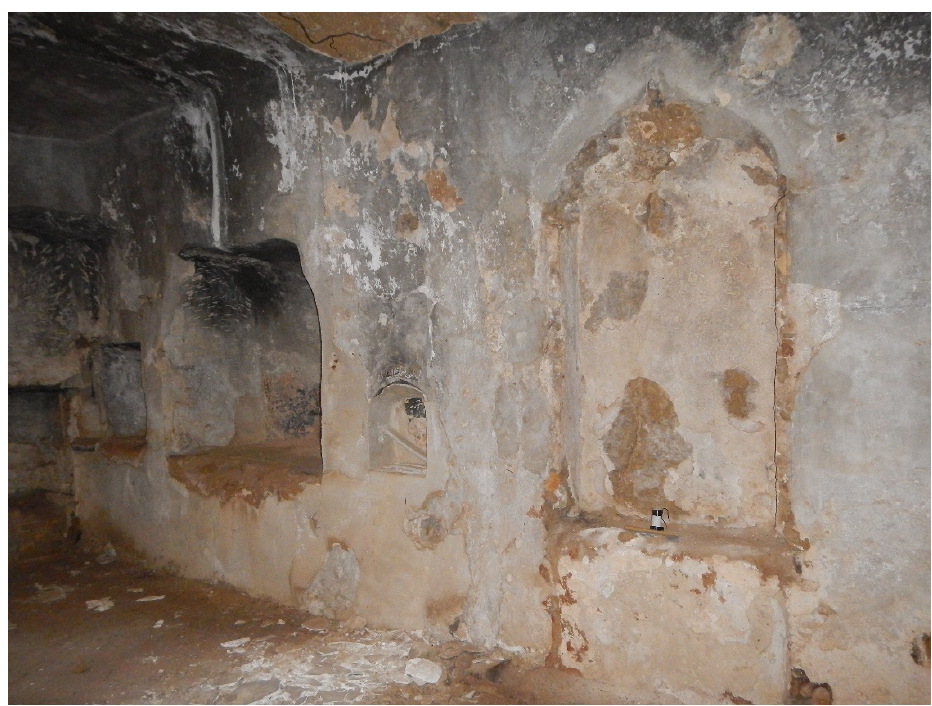
Figure 4. View of the east wall, St. Mary of the Cave, Famagusta (Photo: Andreas